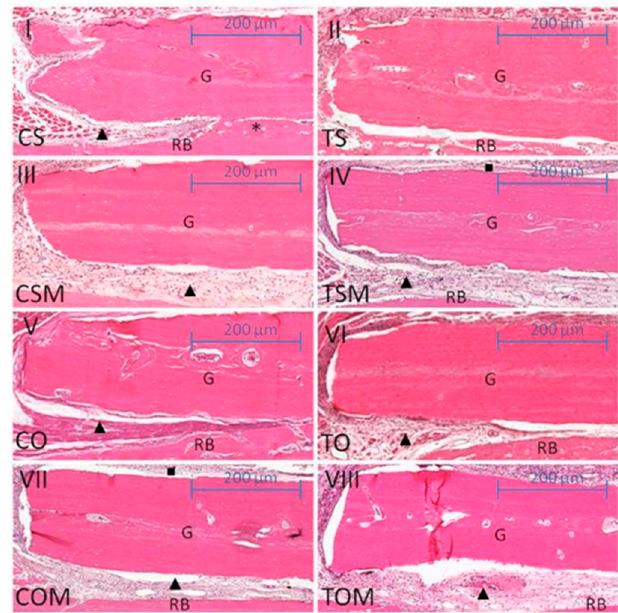
Figure 1. Scanned images for histomorphometric analysis of 21 days. ( I ) subgroup non-smoking and